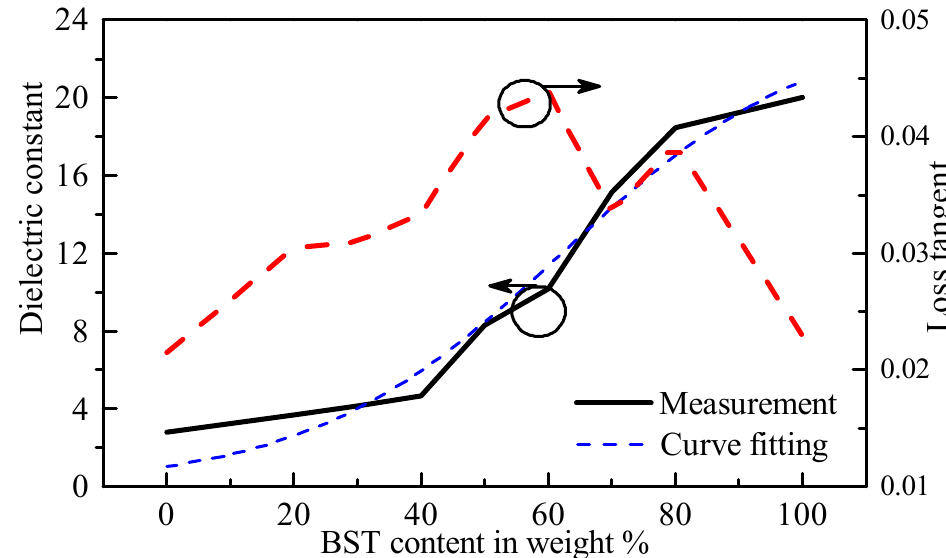
Figure 4. Dielectric constant and dielectric loss tangent of the dielectric paste. The BST content is given in weight percent. A sigmoid curve fit is shown in the graph as well for the dielectric constant of the paste.